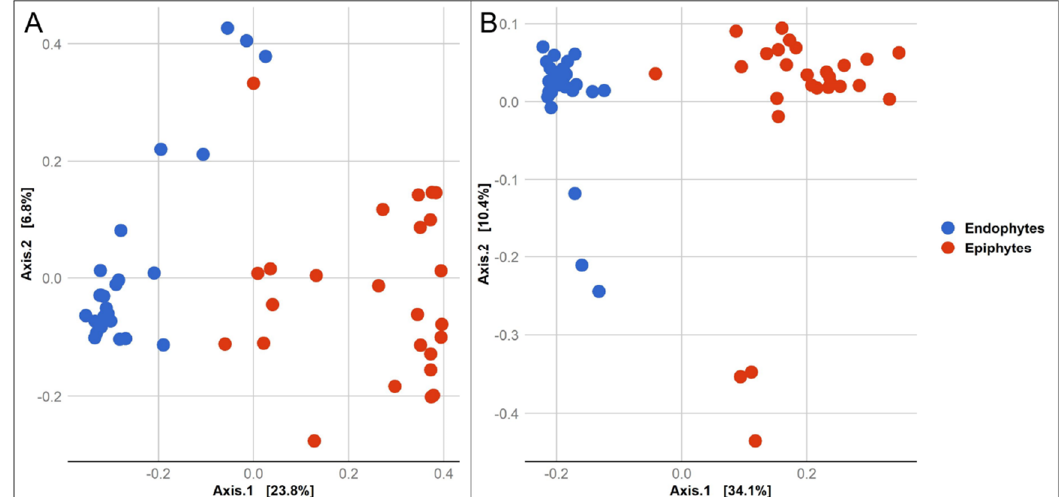
Figure 4. Principal coordinate analysis (PCoA) based on the beta diversity Bray Curtis dissimilarity metrics, showing the distance in the wheat grain-associated bacterial ( A ) and fungal ( B) communities between endophytic and epiphytic mi- crobes.